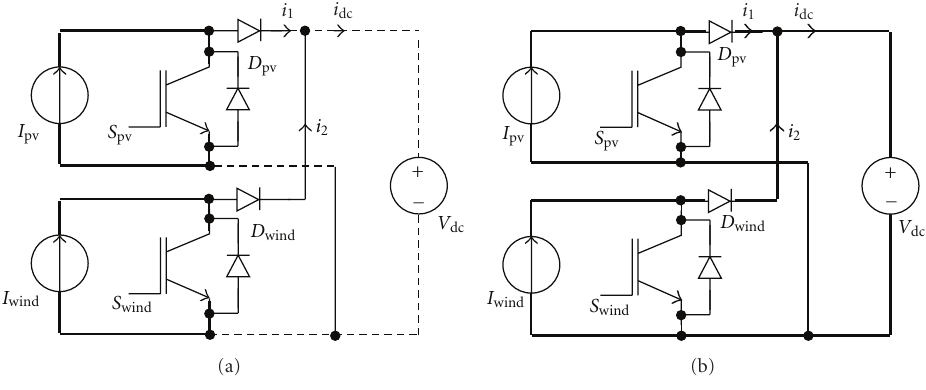
Figure 6: DC-side operation—(a) v m < v cr and (b) v m > v cr